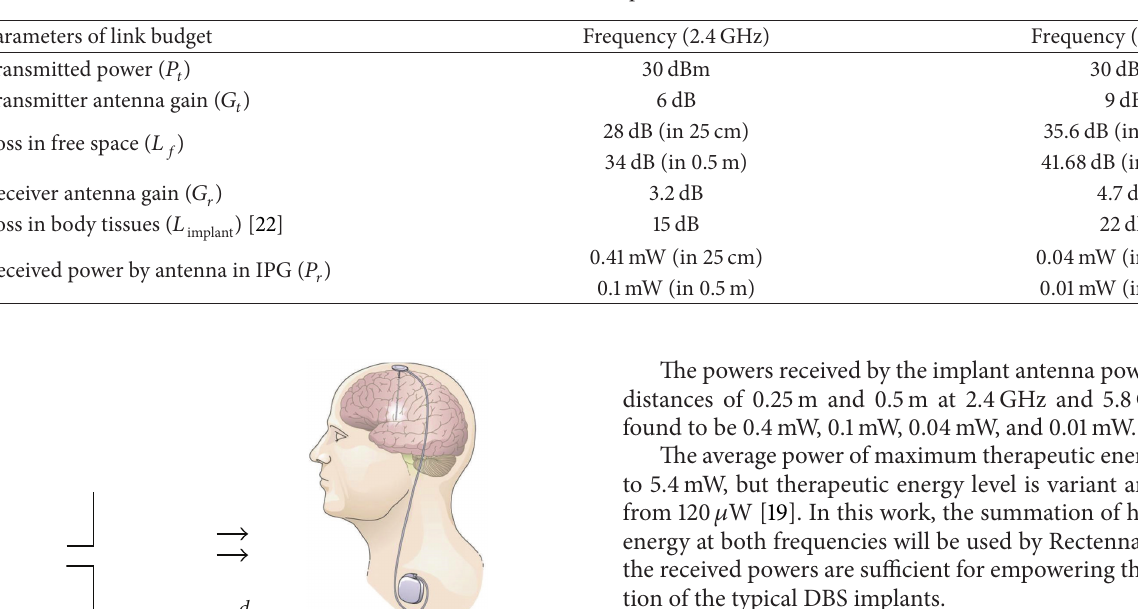
Table 2: Parameters and results for performance evaluation tests.